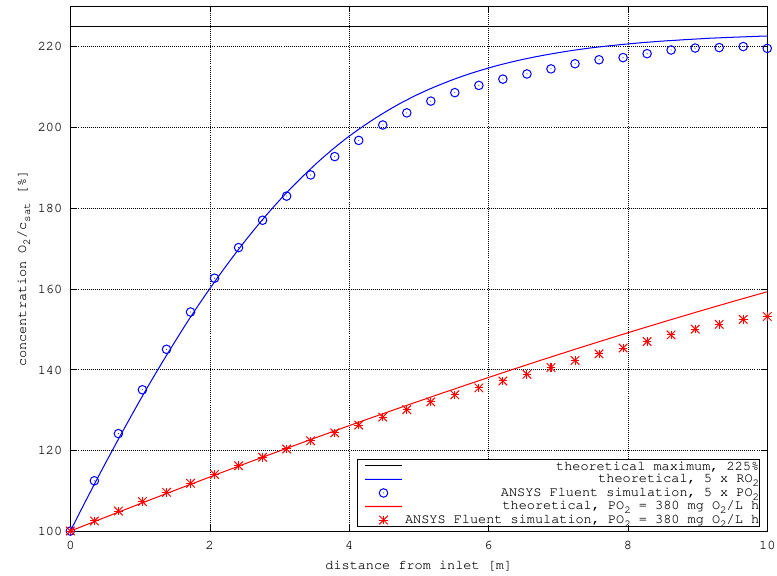
Figure 3. Concentration profiles of dissolved oxygen along the thin-layer reactor (along almost horizontal line traced 5 mm from the bottom) and comparison of CFD simulations results with solution of Equation (7). Two variants of maximum value PO 2,max are depicted here, the basic value 380mgO 2 /Lh, and 5 times larger value approaching the maximum possible concentration representing 225% of the saturated value (depicted as horizontal line at the top of the